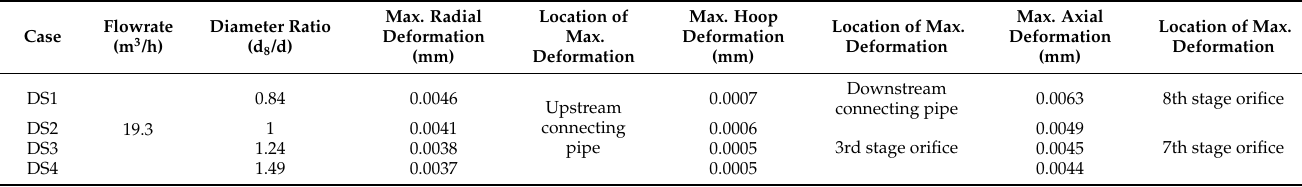
Table 9. The predicted results of deformation components depending on the size of the hole diameter (d 8 ) in the eighth orifice